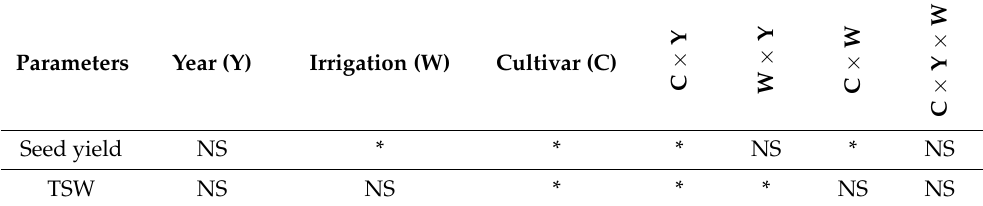
Table 1. Analysis of variance results (significance of the effects) for testing the effects (main and interactions) of year (Y), irrigation (W), and cultivar (C) on the seed yield and one thousand seed weight